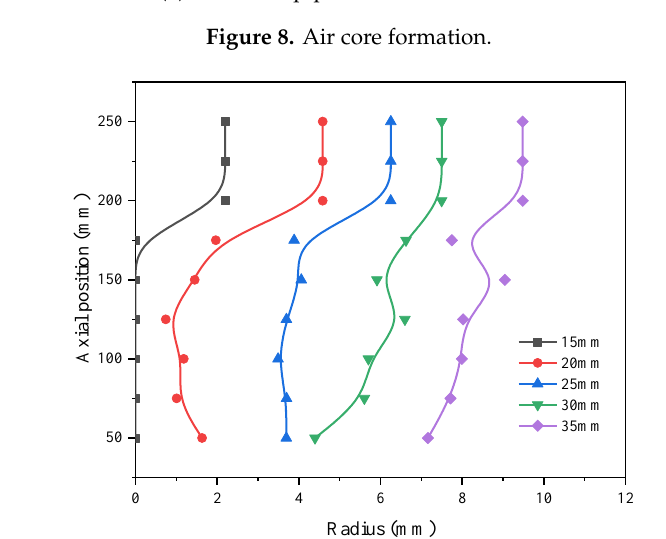
Figure 9. The air core diameter.